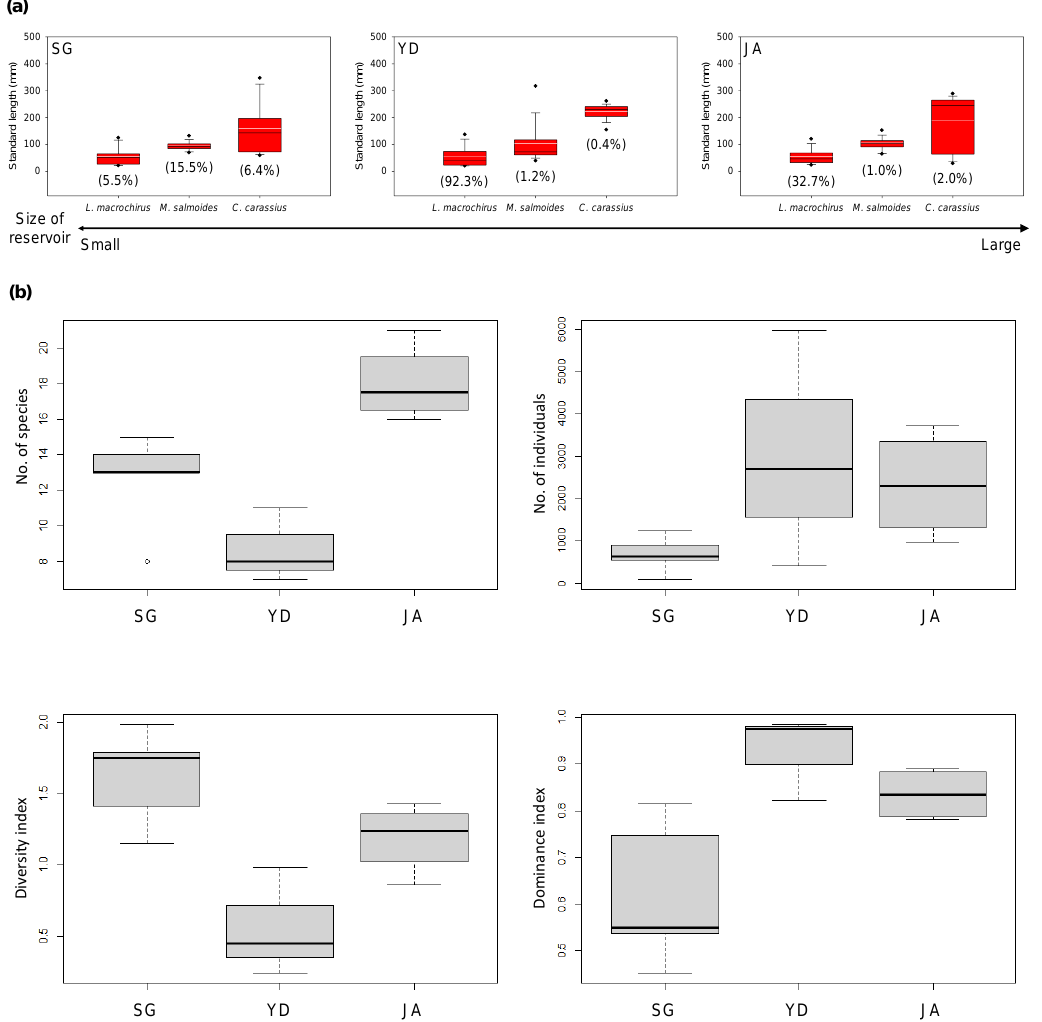
Figure 3. ( a ) The range of the standard length for the major species sampled from the SG, YD, and JA in Korea. The black lines represent the median value, and the white lines represent the average value. A number between brackets means the relative abundance. ( b ) The mean community structure values from the SG, YD, and JA in Korea.